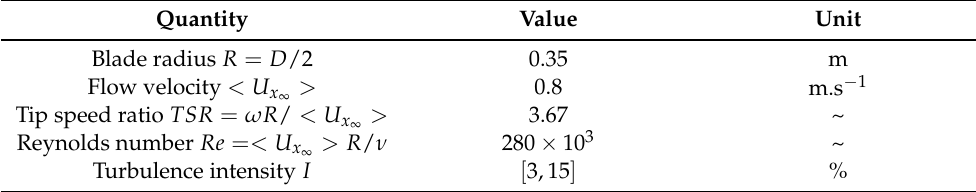
Table 1. Experimental configurations from Mycek et al. [6] studied with the LBM-LES. Quantity